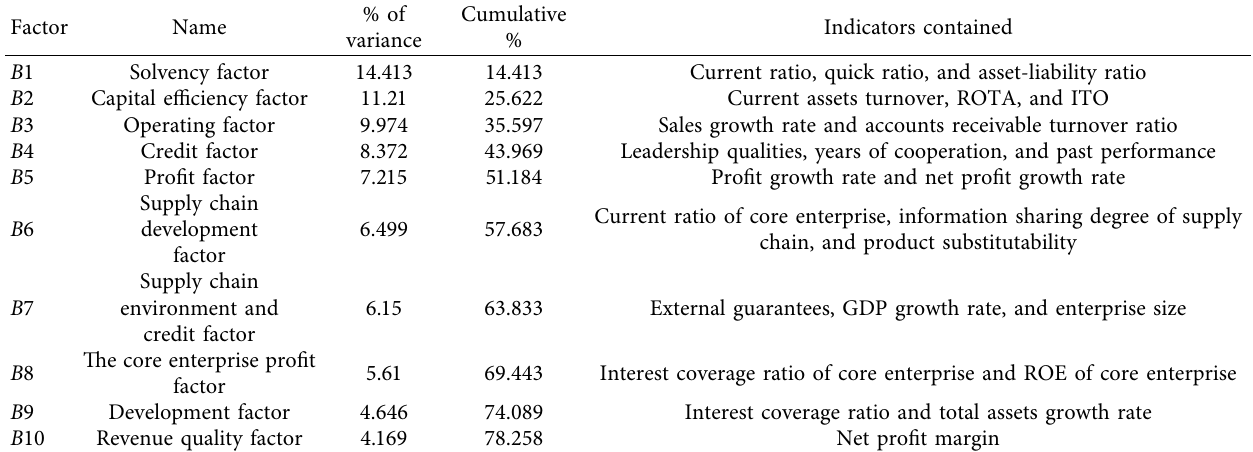
Table 6: Factor explanation table (home appliance industry).